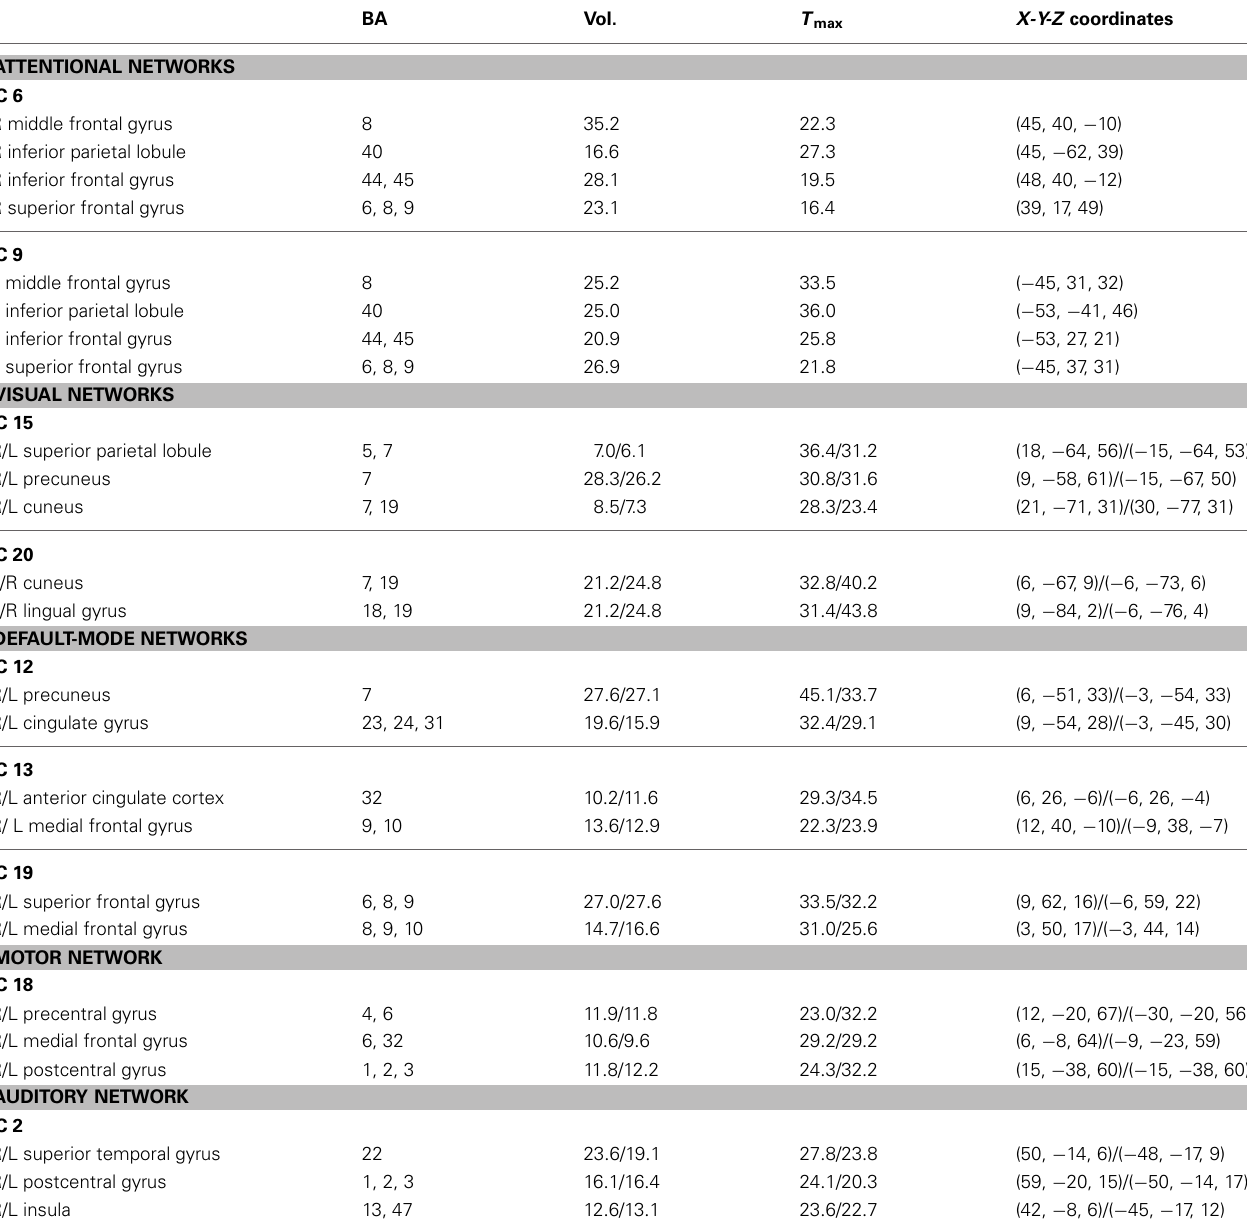
Table 1 | Brain regions, corresponding Brodmann areas, volumes, maximum t -values and spatial coordinates of each component in talairach space. BA Vol. T max X-Y-Z